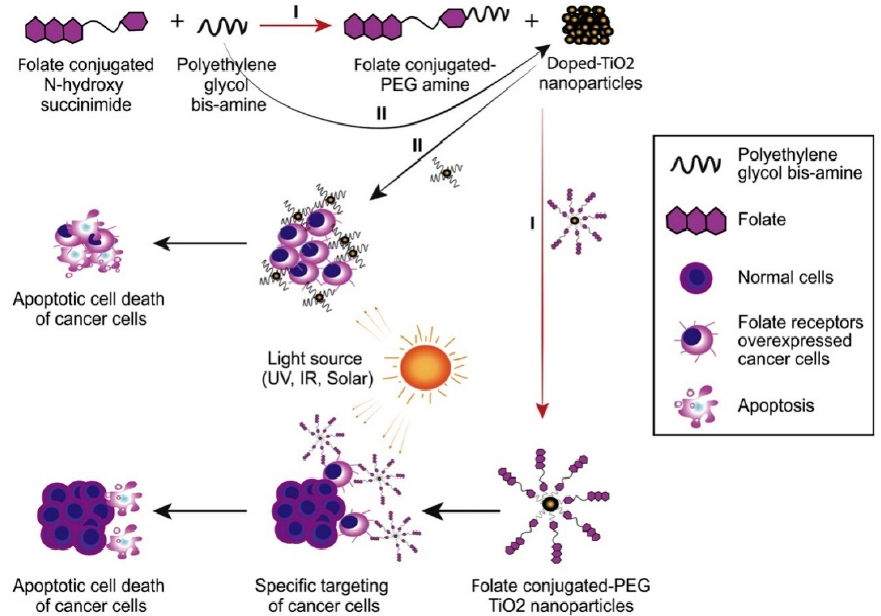
Figure 6. PEGylated doped- and undoped-TiO 2 nanoparticles for cancer-related PDT. Mode of the conjugation of NPs against the cytotoxicity on cervical cancer cells. Reproduced from [91].